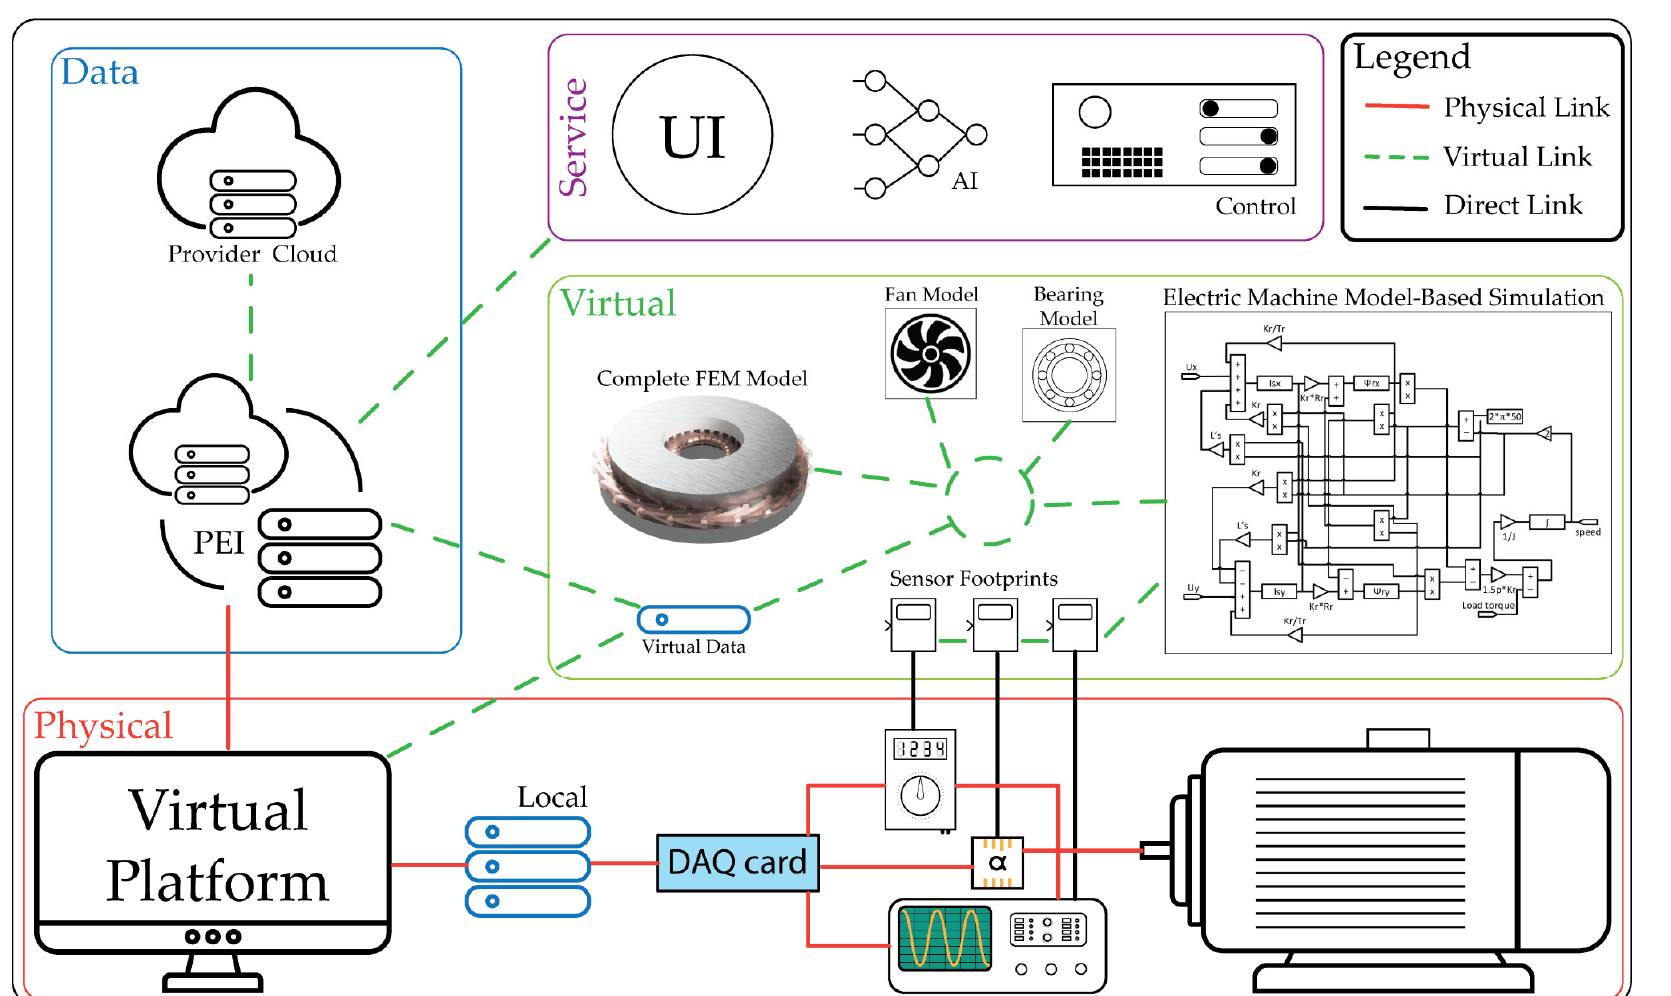
Figure 8. Complete visualization of proposed five-dimensional DTF model, following all paradigms. Sensors and CPU exist in both physical and virtual space. Virtual links established by software links. Physical connections are either wired or wireless. The Simulink model illustration from [54], FEM icon from [55].